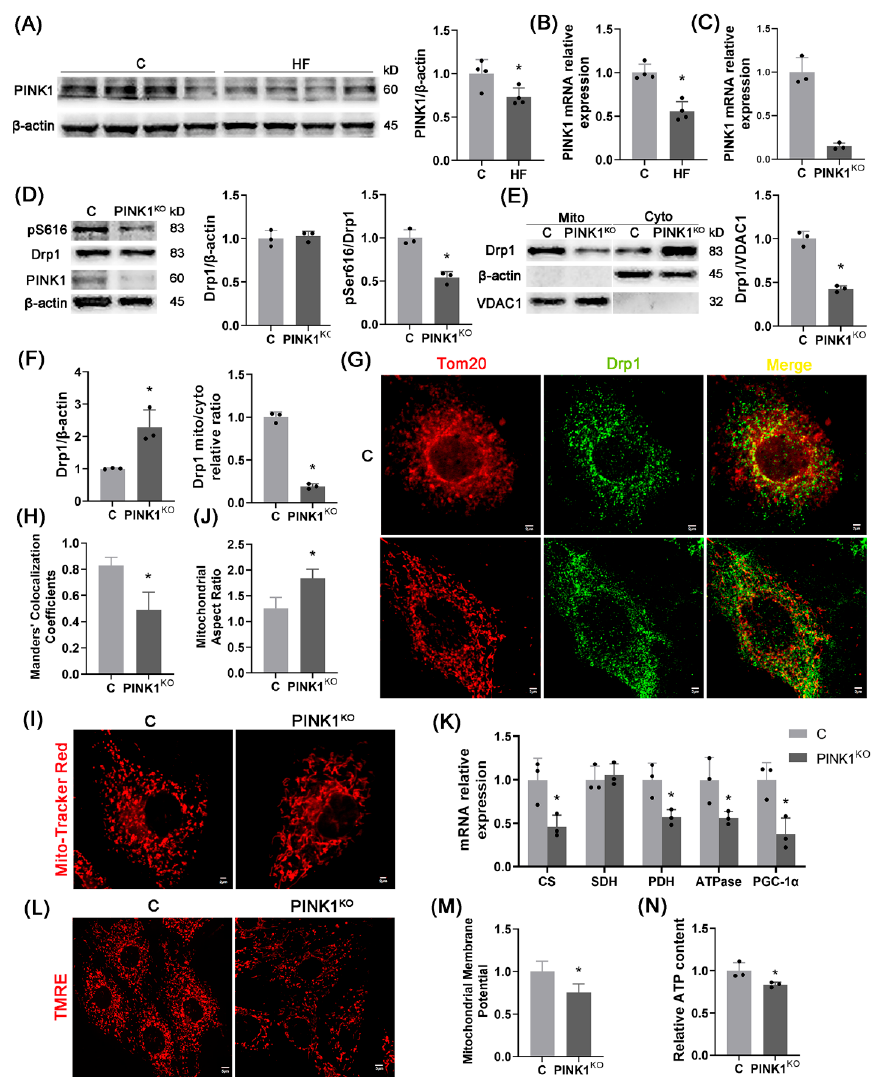
Figure 4. PINK1 knockout in H9C2 cardiomyocytes impairs mitochondrial fission and function. ( A , B ) PINK1 protein expression ( A ) and mRNA expression ( B ) in the LV; n = 4 per group. ( C , D ) PINK1 mRNA expression ( C ) and PINK1 protein expression, Drp1 total protein level and Drp1 S616 phosphorylation level ( D ) in H9C2 cardiomyocytes after PINK1 knockout; n = 3 per group. ( E , F ) Drp1 protein level on mitochondria ( E ) and Drp1 protein level in cytoplasm and relative ratio of mitochondrial Drp1 to cytoplasmic Drp1 ( F ) after separation of mitochondrial and cytoplasmic proteins of H9C2 cardiomyocytes; n = 3 per group. ( G , H ) Representative images of immunofluorescence of H9C2 cardiomyocytes (red: mitochondrial outer membrane marker, Tom20, green: Drp1, blue: DAPI, Scale bar: 2 µ m) ( G ) and Manders co-localization coefficient (MCC) quantitative analysis of Tom20 and Drp1 (more than 30 cells were analyzed per group) ( H ). ( I , J ) Representative images of MitoTracker Red fluorescent staining of mitochondrial morphology (Scale bar: 2 µ m) ( I ) and quantitative analysis of mitochondrial aspect ratio (more than 30 cells analyzed per group) ( J ). ( K ) mRNA expression of mitochondrial function-related genes CS, SDH, PDH, ATPase, and PGC-1 α in H9C2 cardiomyocytes, n = 3 per group. ( L , M ) Representative images of TMRE mitochondrial membrane potential fluores- cence staining (Scale bar: 5 µ m) ( L ) and quantitative analysis of mitochondrial membrane potential fluorescence intensity (more than 30 cells analyzed per group) ( M ). ( N ) Relative ATP content of H9C2 cardiomyocytes (normalized using protein concentration, n = 3 per group). The data are mean ± SD, * Compared with the C group, p <